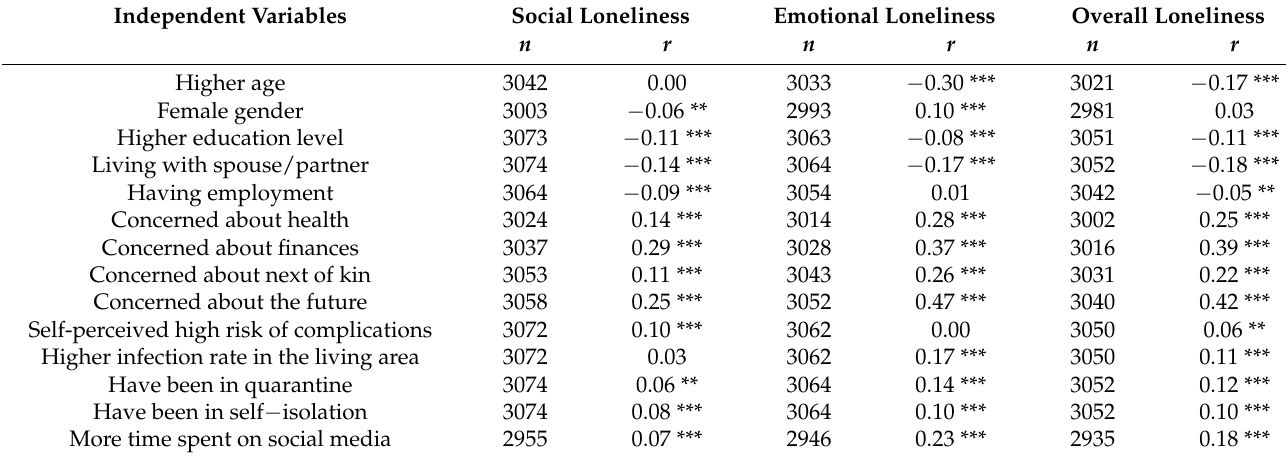
Table 2. Unadjusted (crude) associations between the independent variables and social, emotional, and overall loneliness. Independent Variables